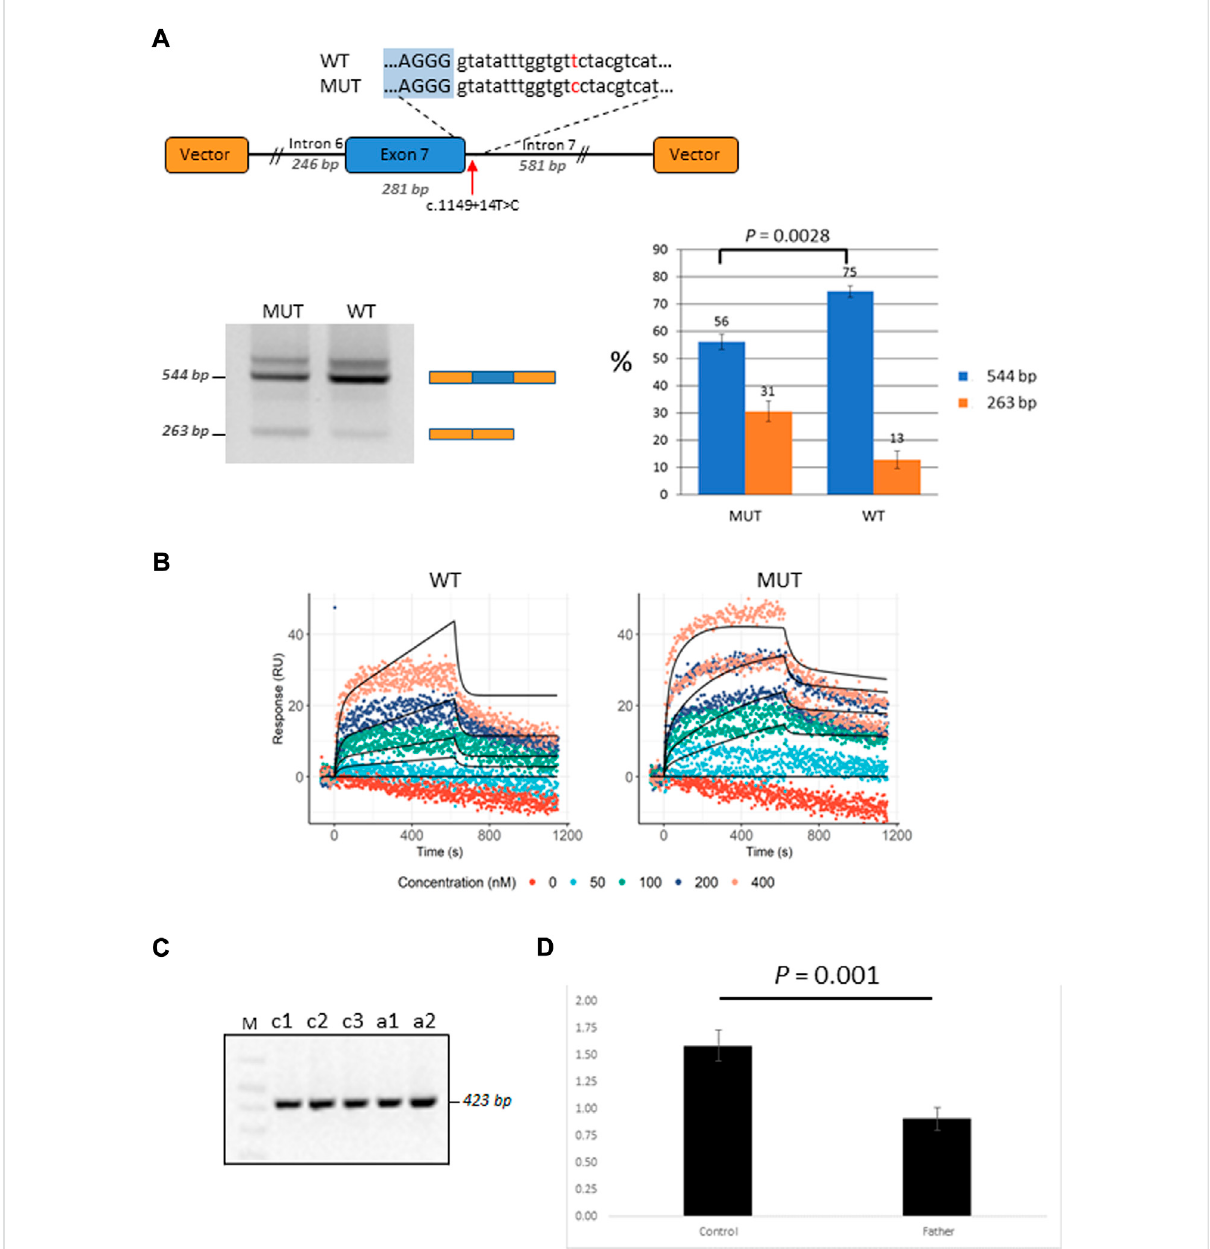
FIGURE 4 Functional characterization of the GBP2 intronic variant c.1149+14T > C. (A) Minigene analysis of c.1149+14T > C. Illustration of the GBP2 minigene. The 5 ′ splice site of exon seven and the downstream sequence covering the c.1149+14T > C variation is enlarged ( top ). RT-PCR analysis of minigene splicing in HepG2 cells. The analysis shows that the minigene carrying the mutant sequence (MUT) has a higher degree of exon seven skipping than the minigene carrying the wild type sequence (WT) ( bottom, left ). Quanti fi cation of the exon seven inclusion and exclusion rates (blue and orange columns, respectively). The inclusion/exclusion is quanti fi ed on a Fragment Analyzer instrument and represent the intensity of the 544bpor263bpbandsoverthetotalintensityinthelane( bottom,right ). (B) SPRimeasurementsofhnRNPA1(splicingsilencerfactor)bindingtothe WT (theleft handside) and MUT(the righthand side)oligonucleotides. Dotscorrespondto therawSPRi measurements while black linescorrespond to the model-implied fi ts. Protein (hnRNP A1) was injected in increasing 2-fold concentrations from 50 to 400 nM shown in color dots. (C) RT-PCR analysisofc.1149+14T > CfromthemRNAofthemutationcarrier(thefatherofP2;samples:c1andc2)andthreehealthycontrols(samples:a1,a2and a3). (D) qRT-PCR analysis of total GBP2 mRNA from whole blood in the carrier (the father of P2) and three healthy controls. GBP2 transcript levels were normalized by RPL13A expression. The values presented are the medians of duplicate determinations